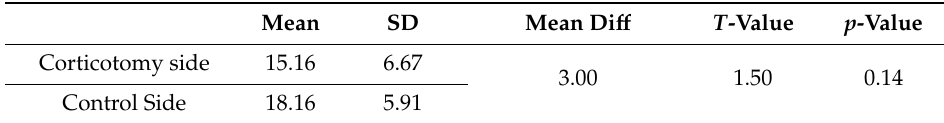
Table 4. Comparison of the amount of canine rotation in the partial corticotomy side and the control side (to the nearest 0.5 degrees).